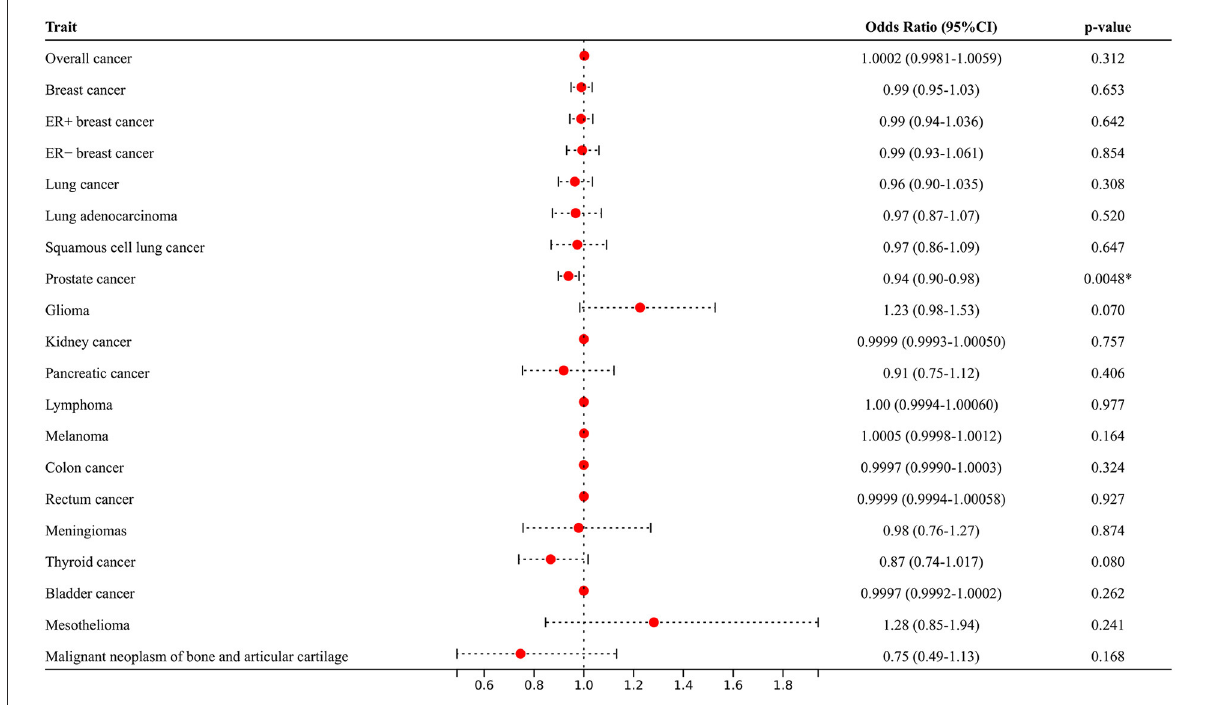
FIGURE3 Multivariable Mendelian randomization analyses adjusted for smoking, alcohol consumption, diabetes, and hypertension. * Means statistically